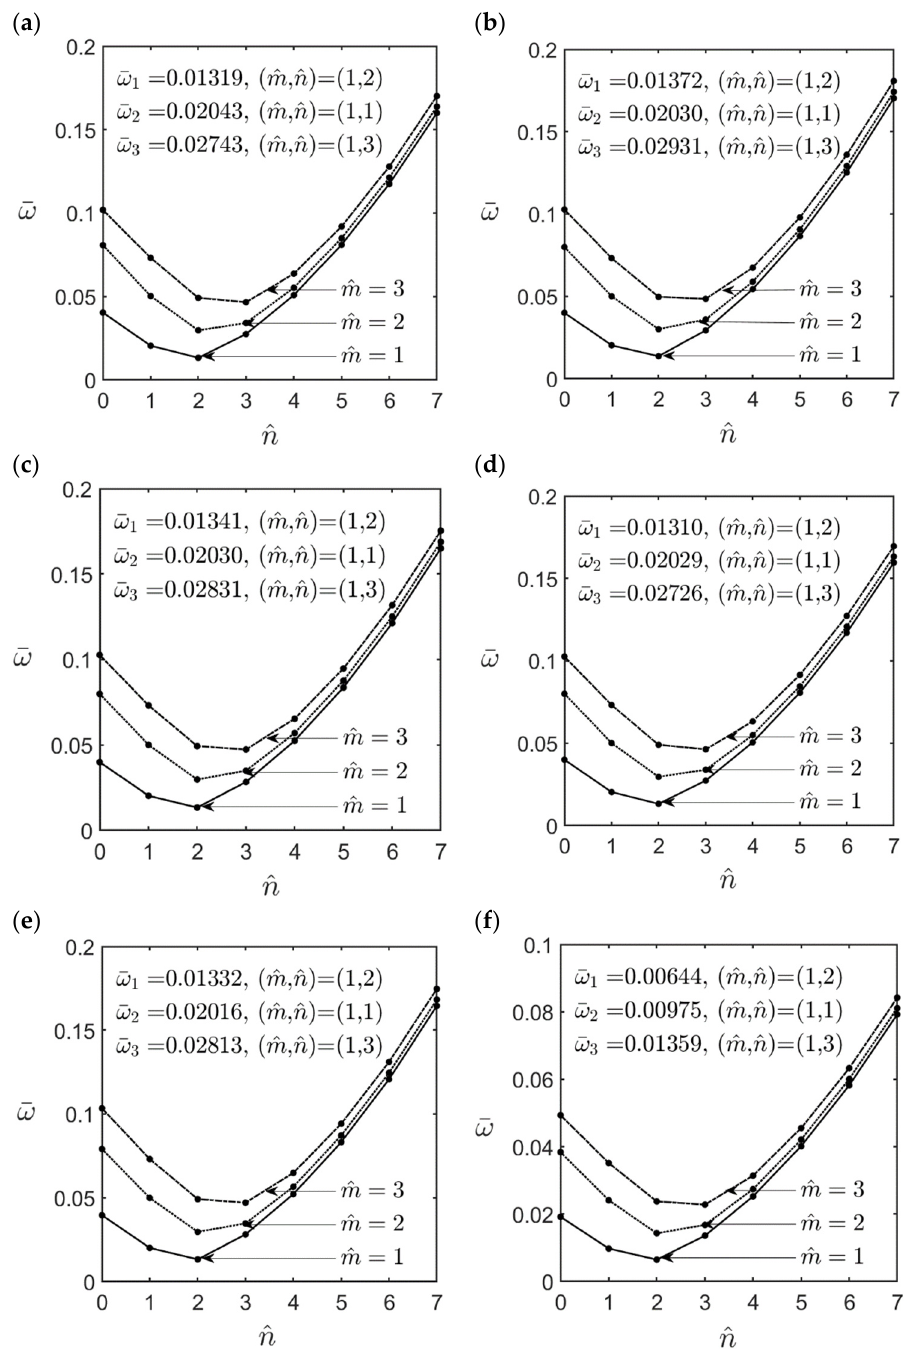
Figure 4. Variations in the lowest dimensionless natural frequencies of an FG-GPLRC thin cylindrical microshell with the wave number pairs ( ˆ m , ˆ n ) , for which R / h = 20, L / R = 5, ˆ l / h = 1.0, W ∗ GPL 0.01, and for the cases of ( a ) FG V-type, ( b ) FG X-type, ( c ) UD, ( d ) FG O-type, ( e ) FG A-type GPL distribution patterns, and ( f ) homogeneous epoxy.